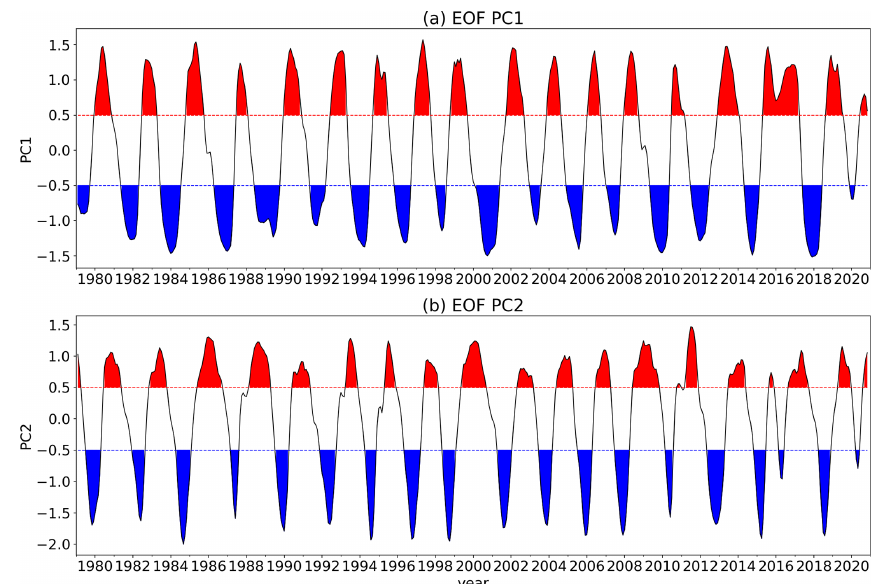
Figure 1. Time series of the first two principal components (PCs) of QBO from 1979 to 2020, obtained by an EOF analysis applied to the Free University of Berlin (FUB) QBO data from 70 to 10hPa. (a) PC1, indicating the QBO phase in the middle stratosphere at 20hPa. (b) PC2, indicating the QBO phase in the lower stratosphere at 50hPa. Red/blue colours are shaded where the QBO indexes are greater/less than half of its standard deviation, indicating the QBOW/QBOE phases.